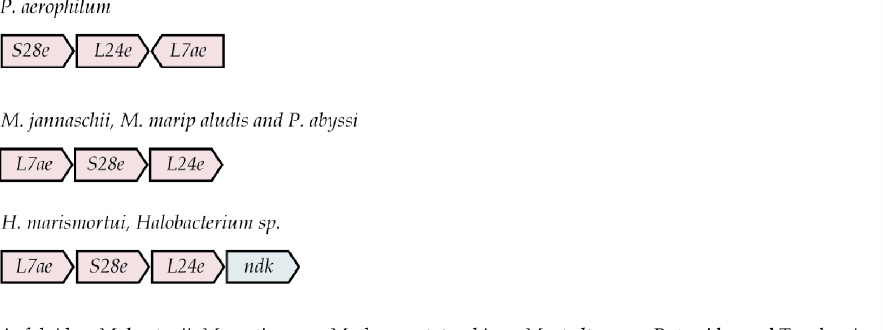
Figure 6. Alternative arrangement of ribosomal protein genes in the S28e - L24e gene cluster. Notation is as in Figure